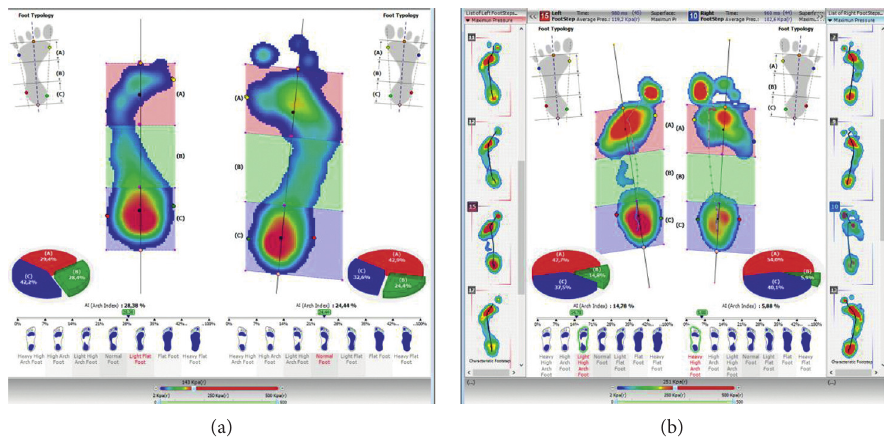
Figure 12: (a) The result of the foot arch examination when standing. (b) The result of foot arch examination while walking: patient no.